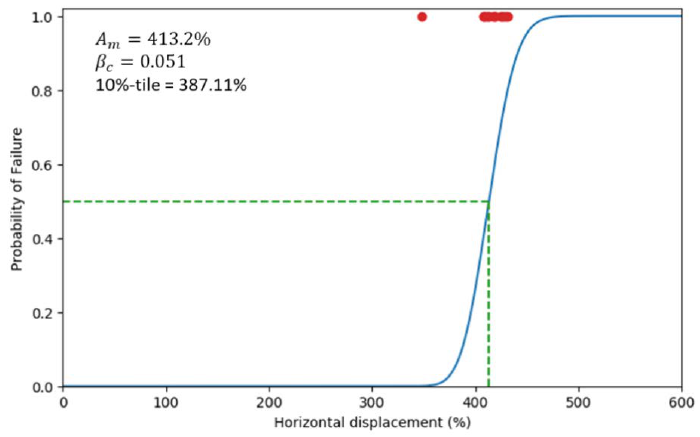
Figure 18. Probability of shear failure.